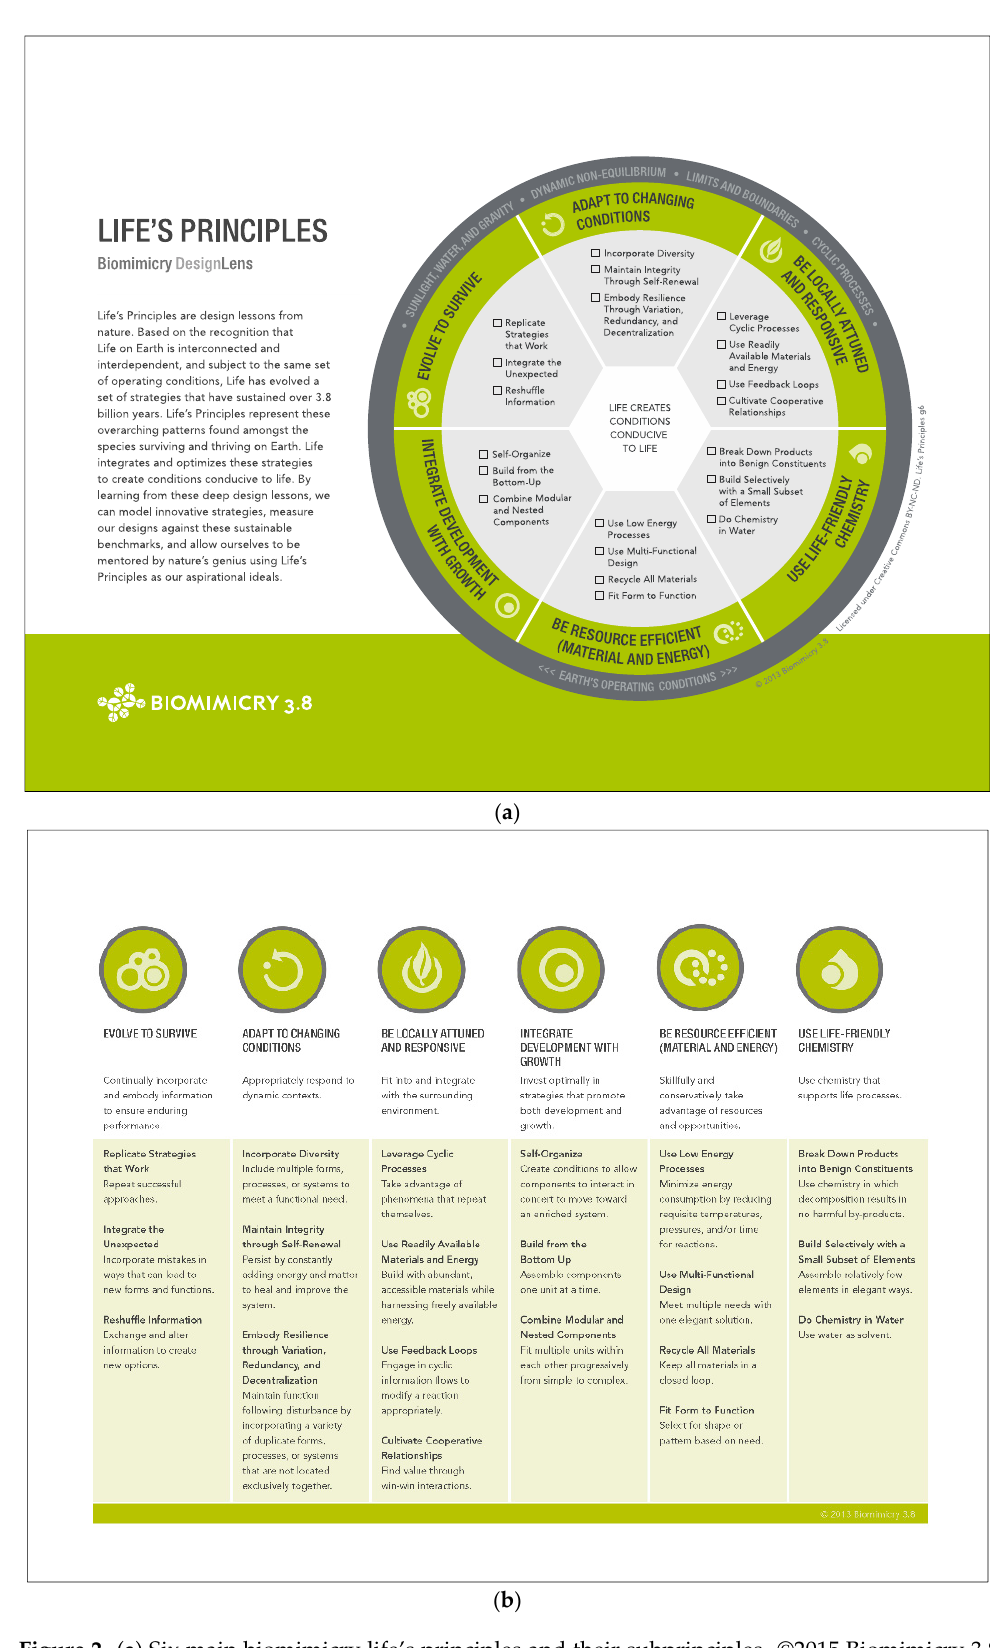
Figure 2. ( a ) Six main biomimicry life’s principles and their subprinciples. ©2015 Biomimicry 3.8. CC BY-NC-ND. Permission granted by Biomimicry 3.8 under Creative Commons. ( b ) Six main biomimicry life’s principles and their subprinciples. ©2015 Biomimicry 3.8. CC BY-NC-ND. Permission granted by Biomimicry 3.8 under Creative Commons.